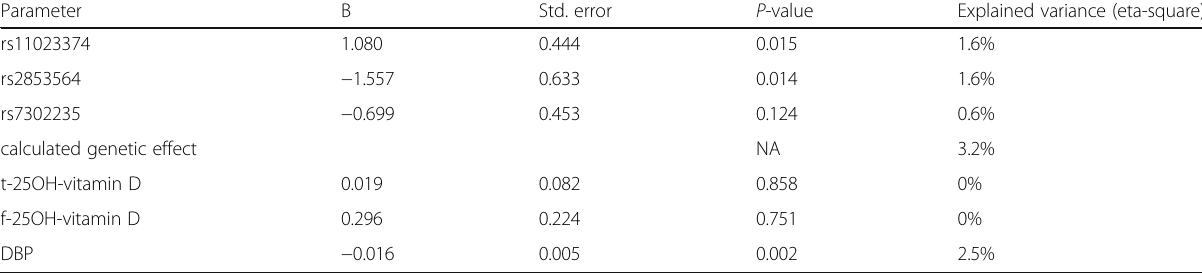
Table 3 Association between BMI and selected genotypes adjusted for vitamin D levels and DBP Parameter B Std. error P -value Explained variance (eta-square)